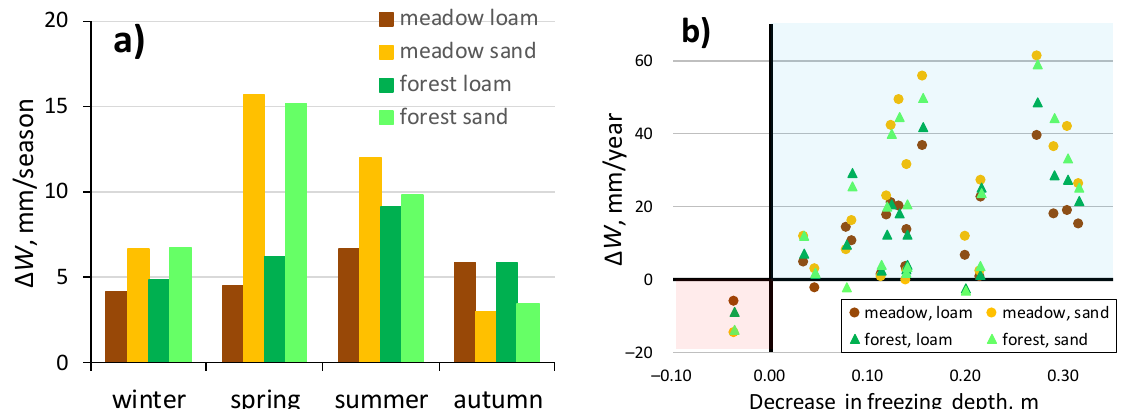
Figure 12. Average seasonal changes in groundwater recharge ∆ W for the central and northern parts of ER ( a ) and the correlation between simulated changes in annual groundwater recharge ∆ W and the observed average decrease in the freezing depth ( b ). Simulation results also show that differences in soil type have a stronger effect on changes in groundwater recharge (Figure 12a) and soil water storage (Figure 13) than soil moisture storage, which is also maximum in the center of the region (Figure 13). differences in vegetation.